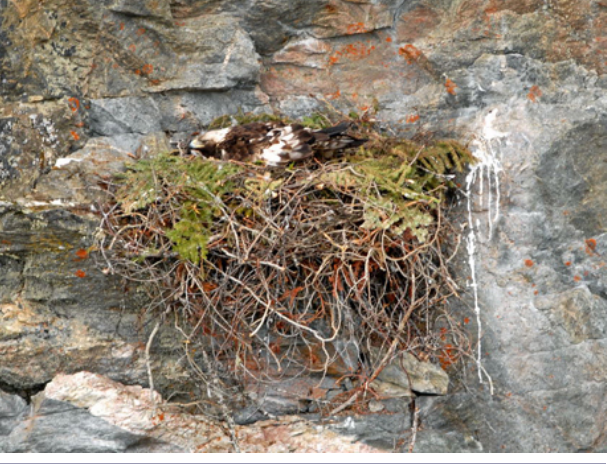
Fig. 2 . Incubating Golden Eagle ( Aquila chrysaetos ) with new and old